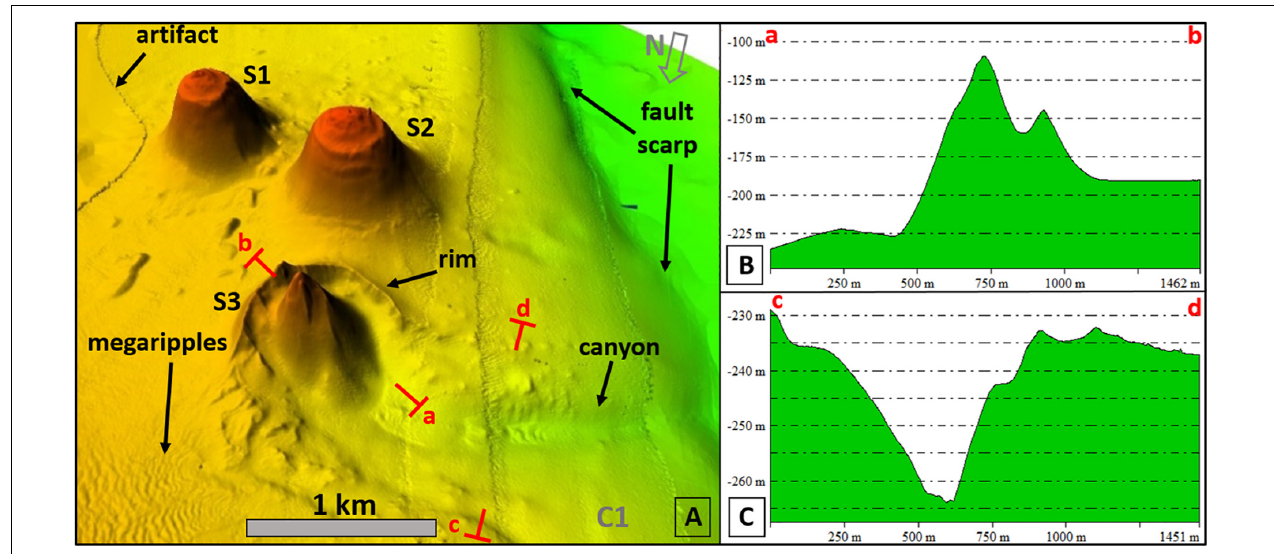
FIGURE 4 | (A) 3D shaded relief image (vertical exaggeration = 4x) of the southernmost cluster of the GVF C1, formed of S1, S2, and S3 seamounts. (B) Bathymetric profile (ab) across the pointy-cone S3. (C) Bathymetric profile (cd) across the canyon developing from the western base of S3.